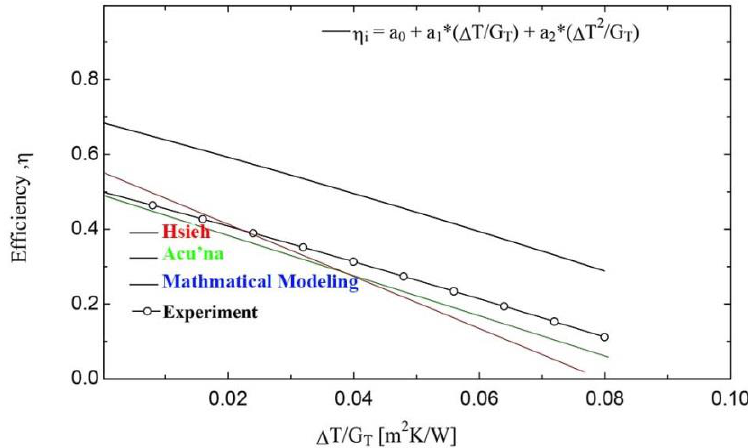
Figure 17. The efficiency of the collector has been compared with the minimum ambient temperature and with similar researches..